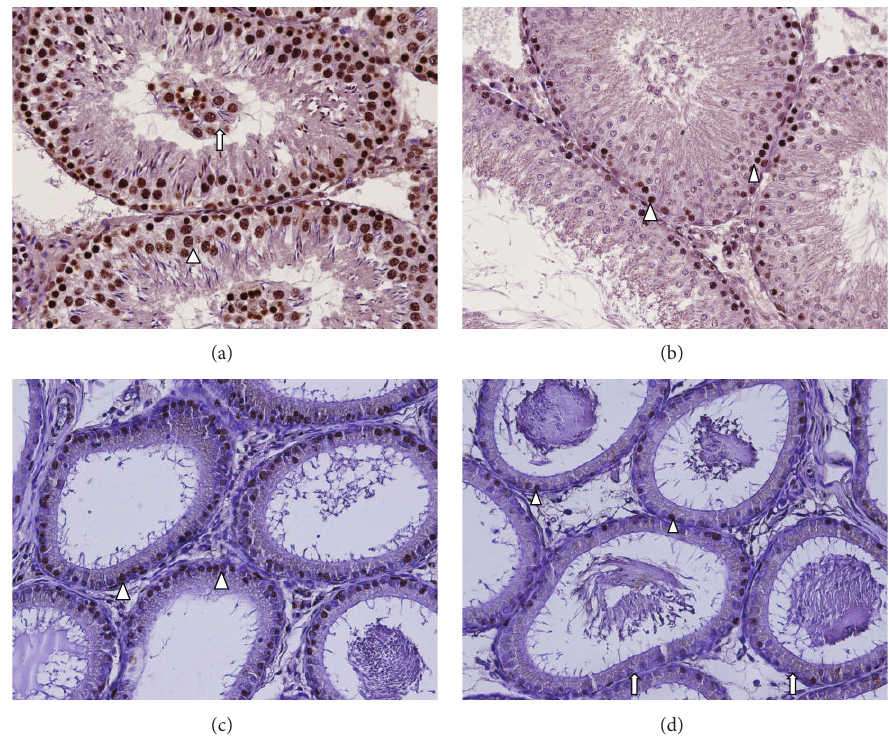
Figure 2: (a) In the MTX group, widespread apoptotic germinal cells in seminiferous tubule germinal epithelium (arrow head) and in the lumen (arrow). (b) In the MTX + RES group, apoptosis was generally present in spermatogonia cells (arrow head). (c) Widespread apoptosis in epididymal epithelium cells (arrow head) in the MTX group. (d) in the MTX + RES group, rare apoptotic cells (arrow head) and widespread normal epithelial cells (arrow) in epididymal epithelium (TUNEL analysis ×